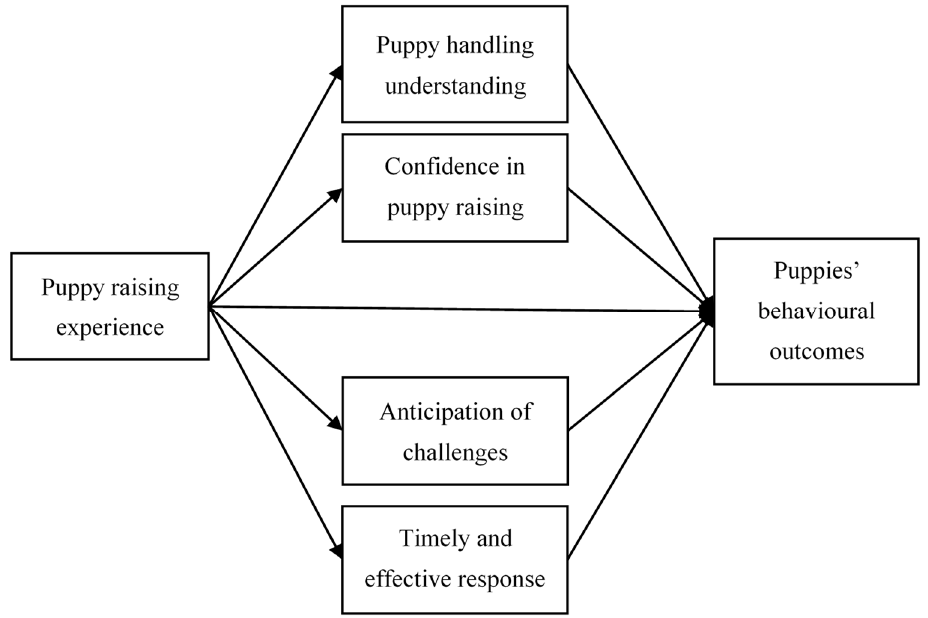
Figure 1. Competency mediates the relationship between raisers’ experience and puppies’ behavioural outcomes.